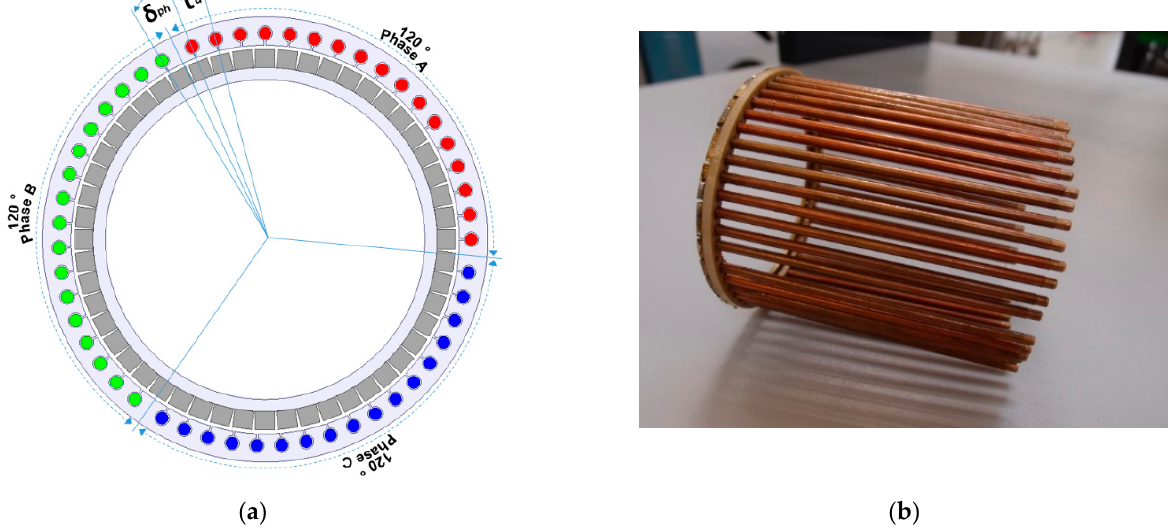
(28) With n number of slot groups per phase equal to 3 or 6. The torque and the e.m.f of the motor depends on the number of slots N S . For our application with n = 3 (as show in Figure 18a) we obtain a number of slots equal to N S = 51. For our configuration the choice of N R = N S + 1 = 52 is related to the dimension of the phase shift tooth. Indeed, there is a risk of saturation of this tooth in the case where N R = 50. The rotor construction is a classic realization whereby the magnets are pasted to the surface and segmented along the motor length (for our prototype we have 3 magnets). The rotor does not have a sleeve. We show, in Figure 19, the photos of the stator and the rotor for another prototype of the same design but of a smaller size.